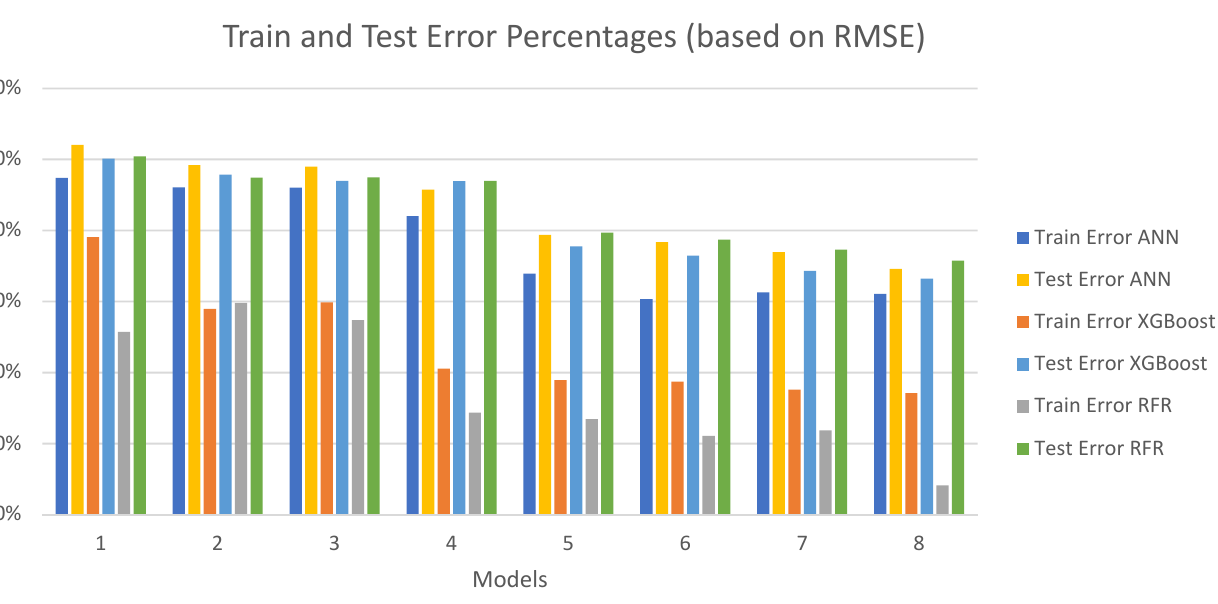
Figure 12. Train and test error percentage (based on the RMSE).